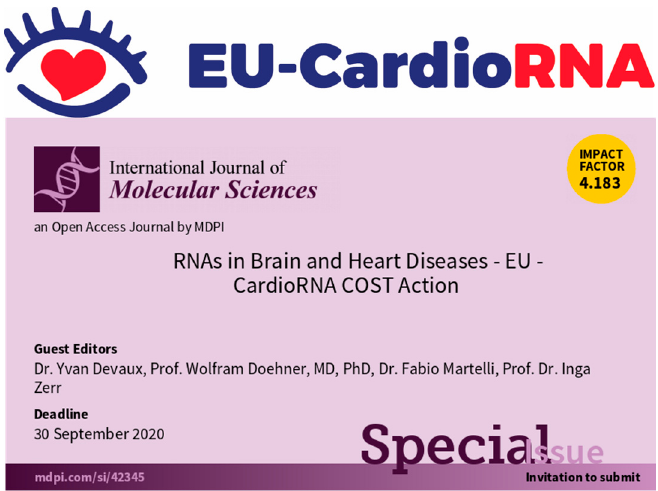
Figure 2. Banner of Special Issue “RNAs in Brain and Heart Diseases - EU-CardioRNA COST Action”.